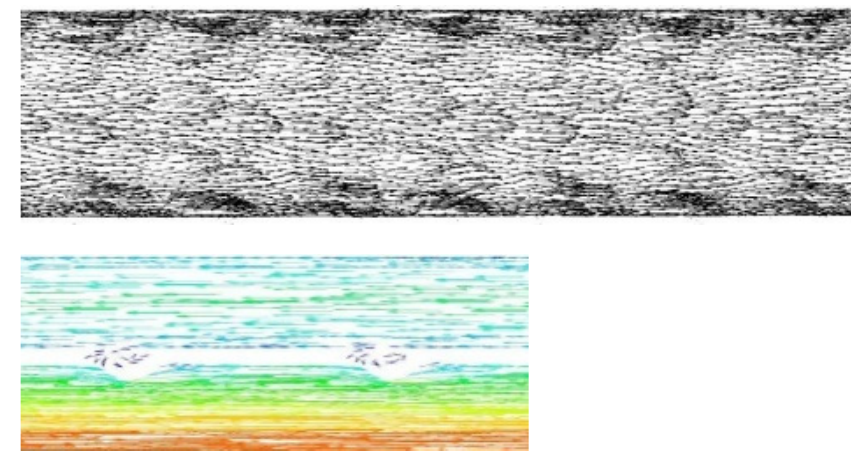
Figure 3. Vector diagram of the flow in and outside the tube.